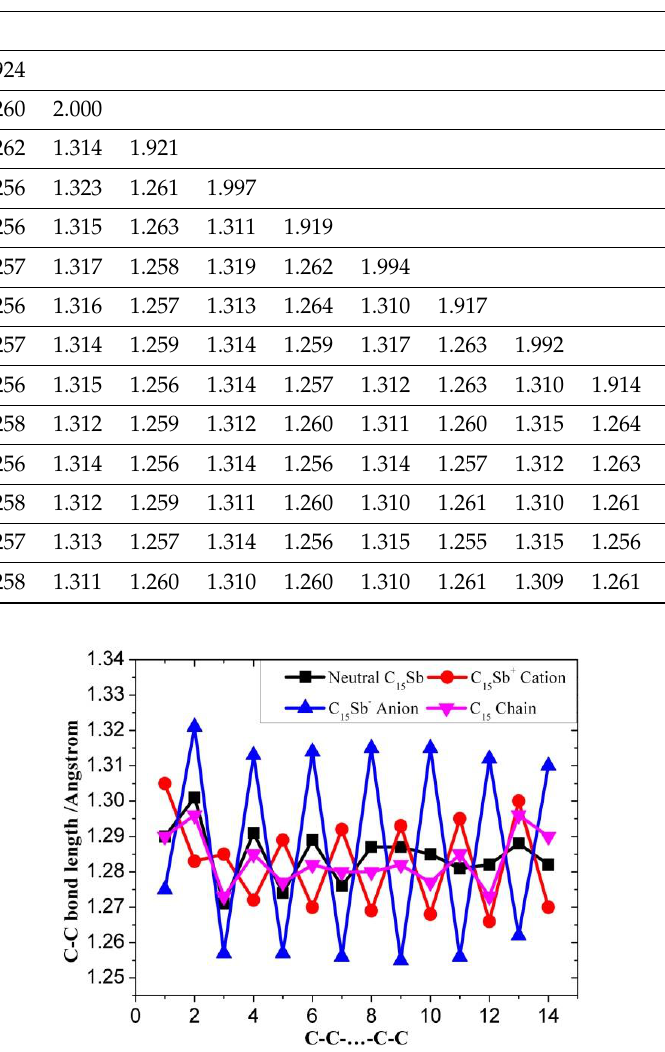
Table 6. The total energies E n , differential energies Δ E n , incremental energies Δ E I , binding ener- gies BE, dipole moments ( μ ), and rotational constants (RC) of C n Sb- anions.